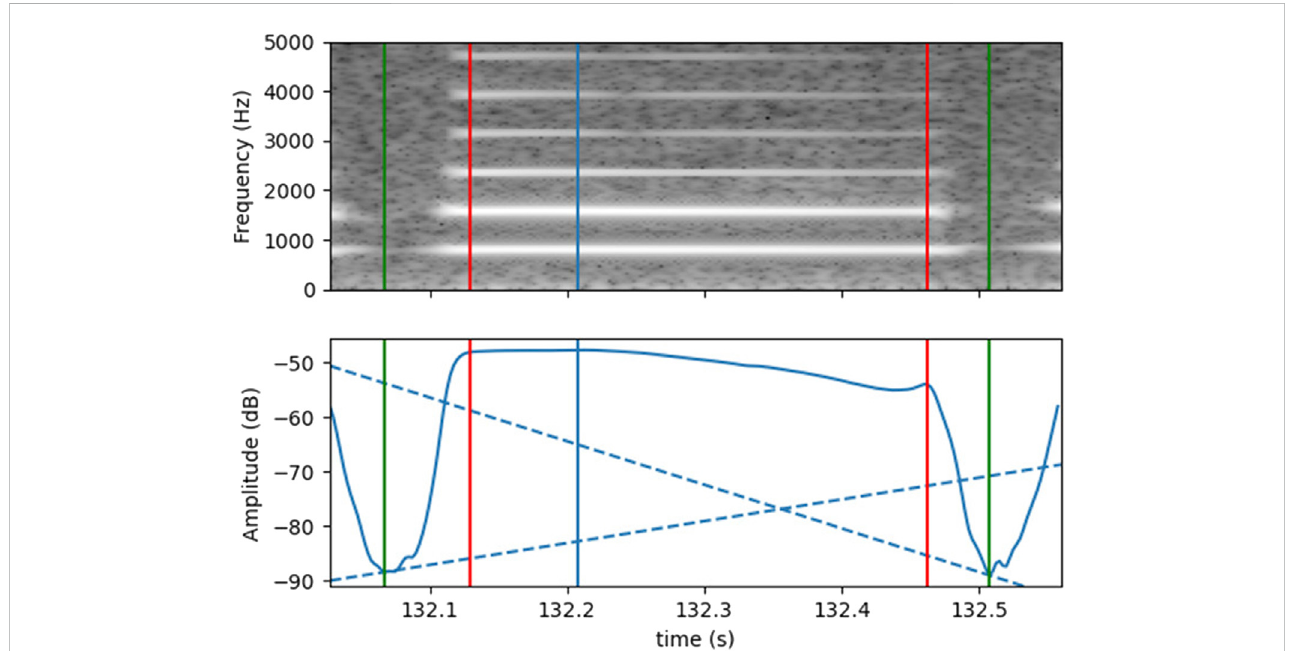
FIGURE 8 Transient detection steps exempli fi edfor asingle note. Top: spectrogram, bottom: amplitude envelope (solid blueline). Dashed lines indicate theslopes subtractedfromtheenvelopeinorderto fi ndcornerpositions(red)whicharemaximaofthesubtractedsignal.Noteboundaries(green)aredetectedfromthe minima before the corner point. Note that for this moderately high note, the even harmonics are not